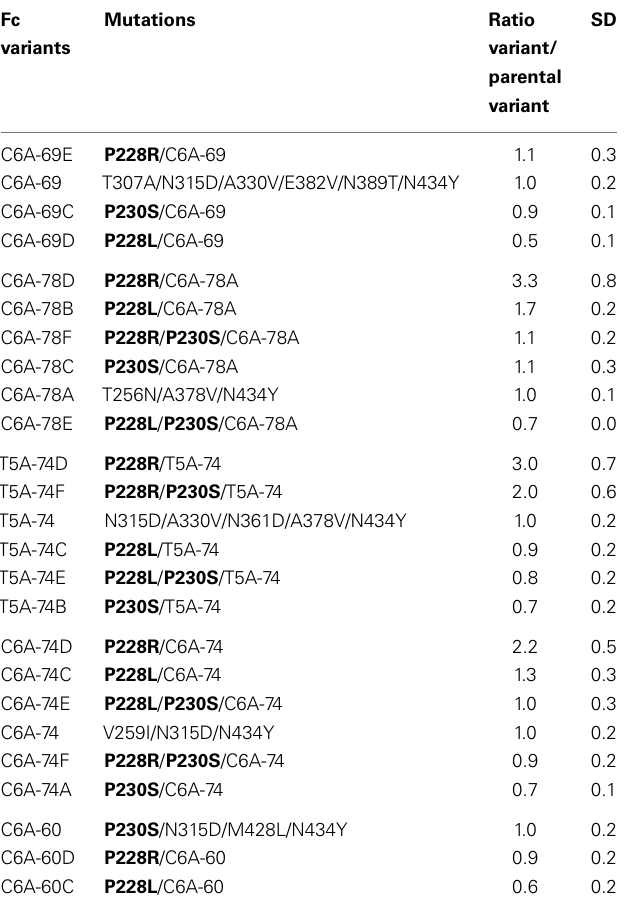
Table 4 | SPR affinity measures at steady state on immobilized recombinant human FcRn of IgG-WT and variants produced inYB2/0